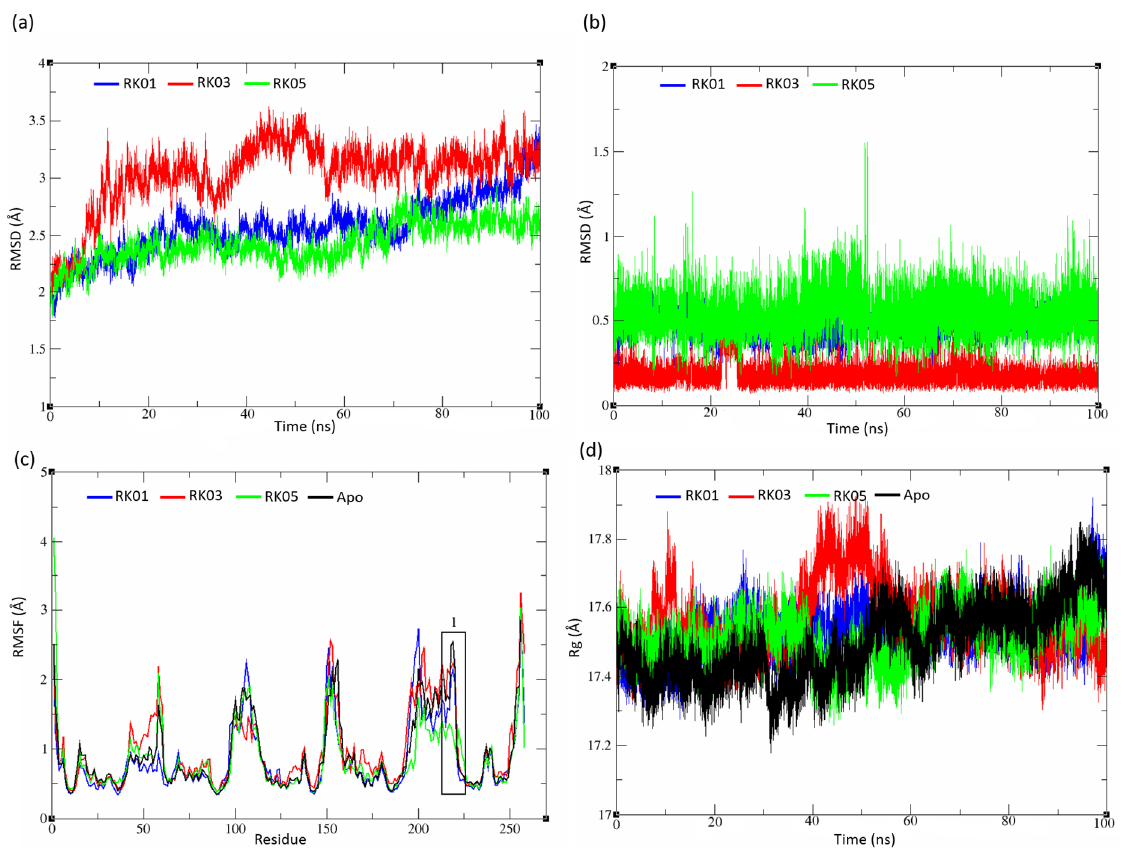
Figure 7. Diverse set analysis. ( a ) Complex RMSD, ( b ) ligand RMSD, ( c ) backbone RMSF, and ( d ) the radius of gyration. RK01 and RK05 reached the stable state after 10 ns of MD simulation compared to RK03, which showed an unstable system through the first 60 ns of MD simulation.